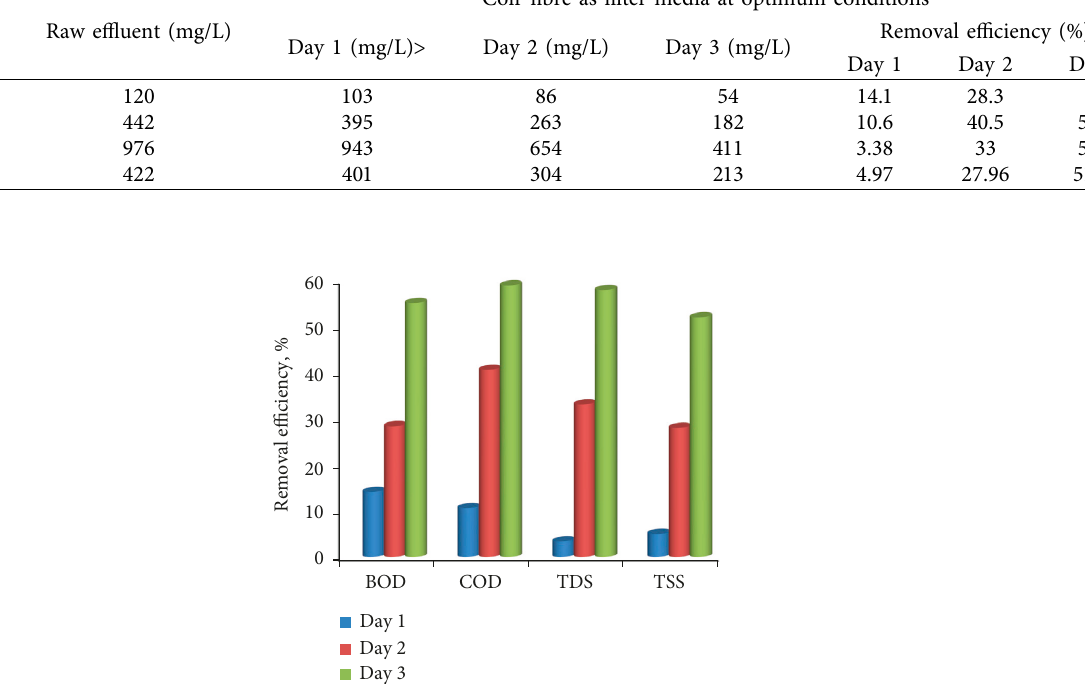
Figure 4: Graphical representation of BOD, COD TDS, and TSS removal using coir fibre with varying the time